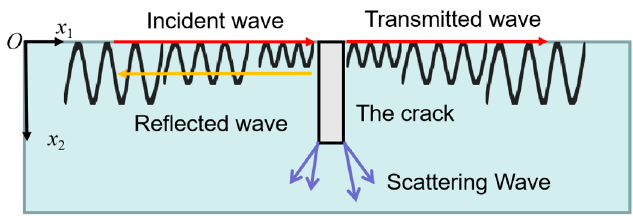
Figure 1. The interaction between an incident Rayleigh wave and the cracks.